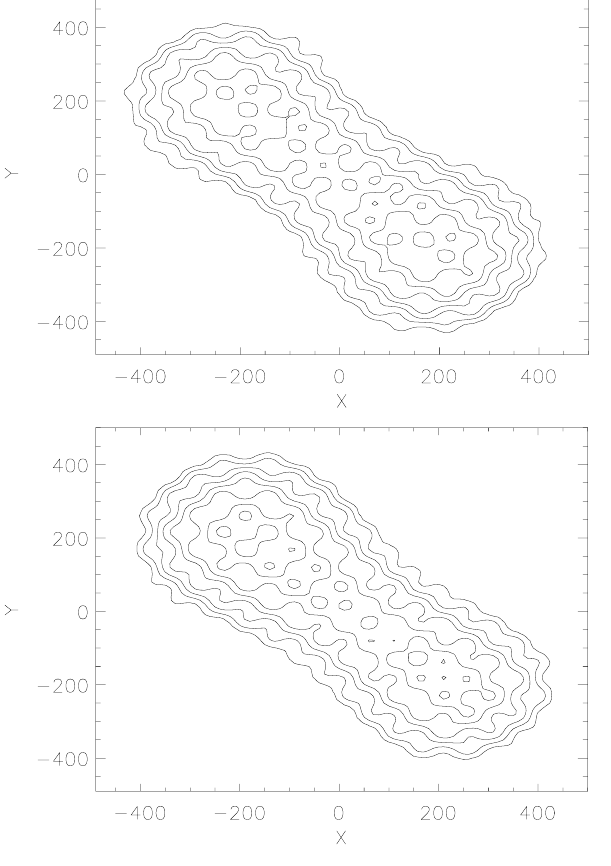
Fig. 2. Model stream function isolines at (a) t = 0 and (b) t = T 1 / 2, with T 1 ∼ 30 days. The boundary of the domain is the zero isoline. The coordinates ( x,y ) are in